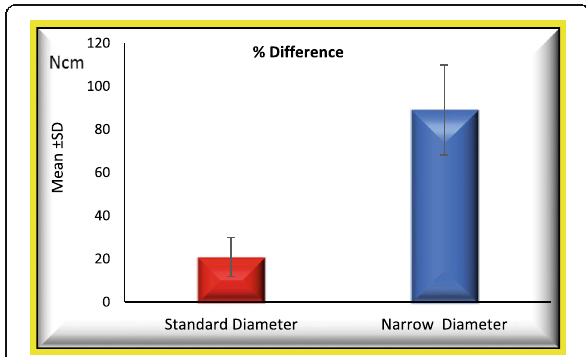
Fig. 7 Mean of percentage difference between initial and post load RTL 1 for GI and GII (regarding use of new abutment